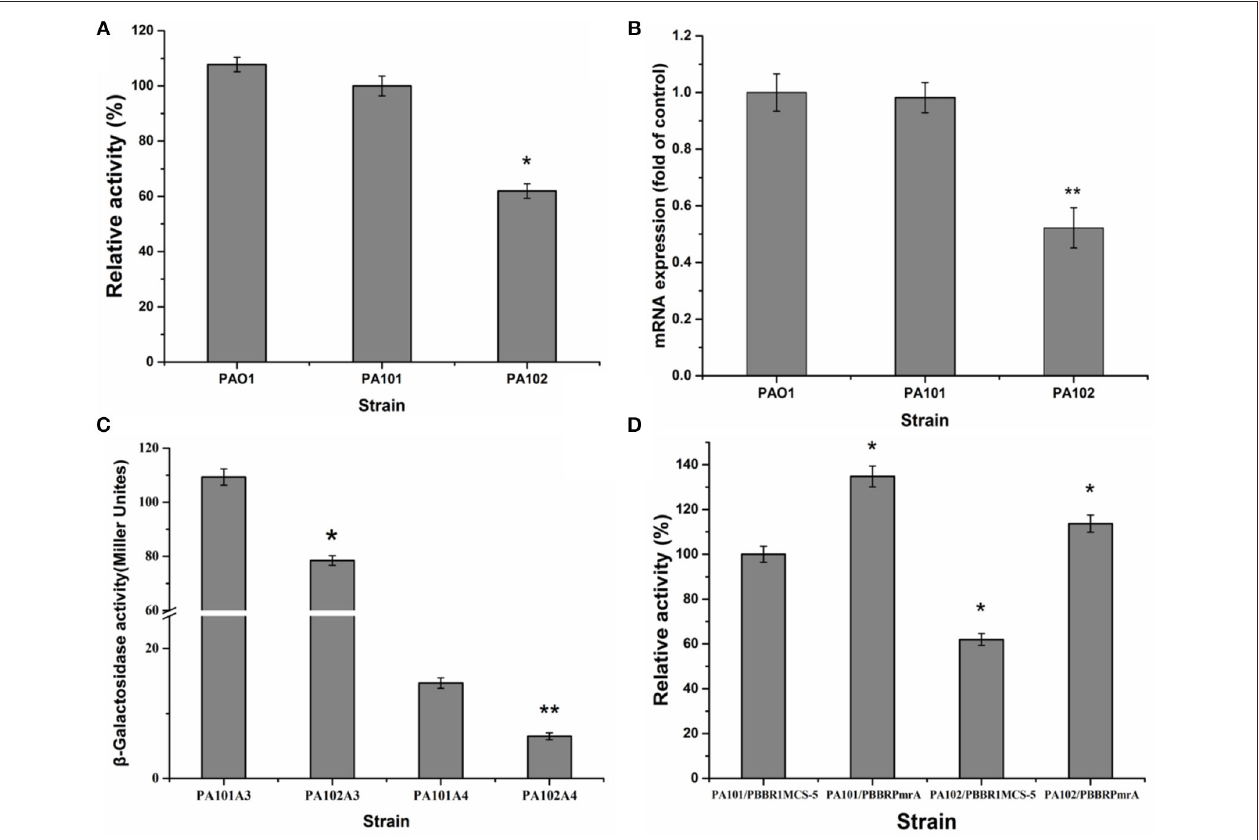
FIGURE 2 | Effect of PmrA on lipA expression. (A) Relative lipase activity in PA01, PA101, and PA102. (B) QRT-PCR of lipA in PA01, PA101, and PA102. (C) Effect of pmrA mutant on expression of translationally fused, chromosome-borne lipA ’-‘ lacZ (control, PA101A4; pmrA mutant, PA102A4) and transcriptionally fused chromosome-borne lipA-lacZ (control, PA101A3; pmrA mutant, PA102A3). After inoculating β -galactosidase into M9 medium (50mL), activity of strains was determined in stationary phase. (D) Relative lipase activity in control strain (PA101) and pmrA mutant (PA102). Experiments were in triplicate. * P < 0.05, ** P < 0.01 compared with control